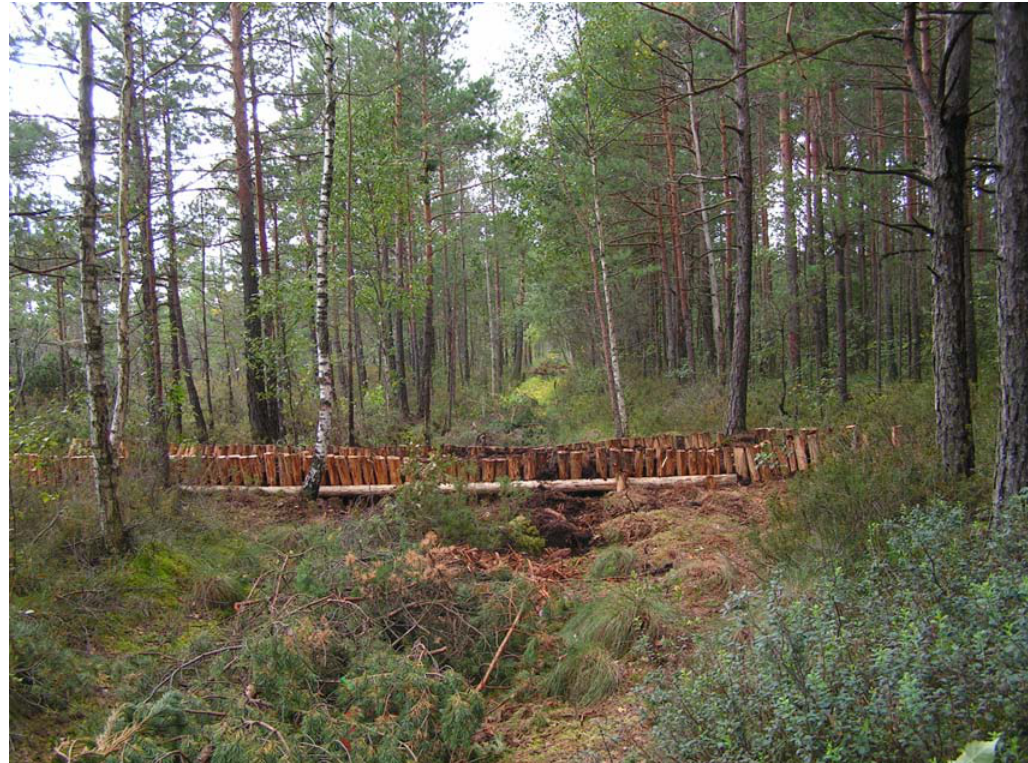
Fig. 6. One of the dams in the drainage ditches in the Kamanos